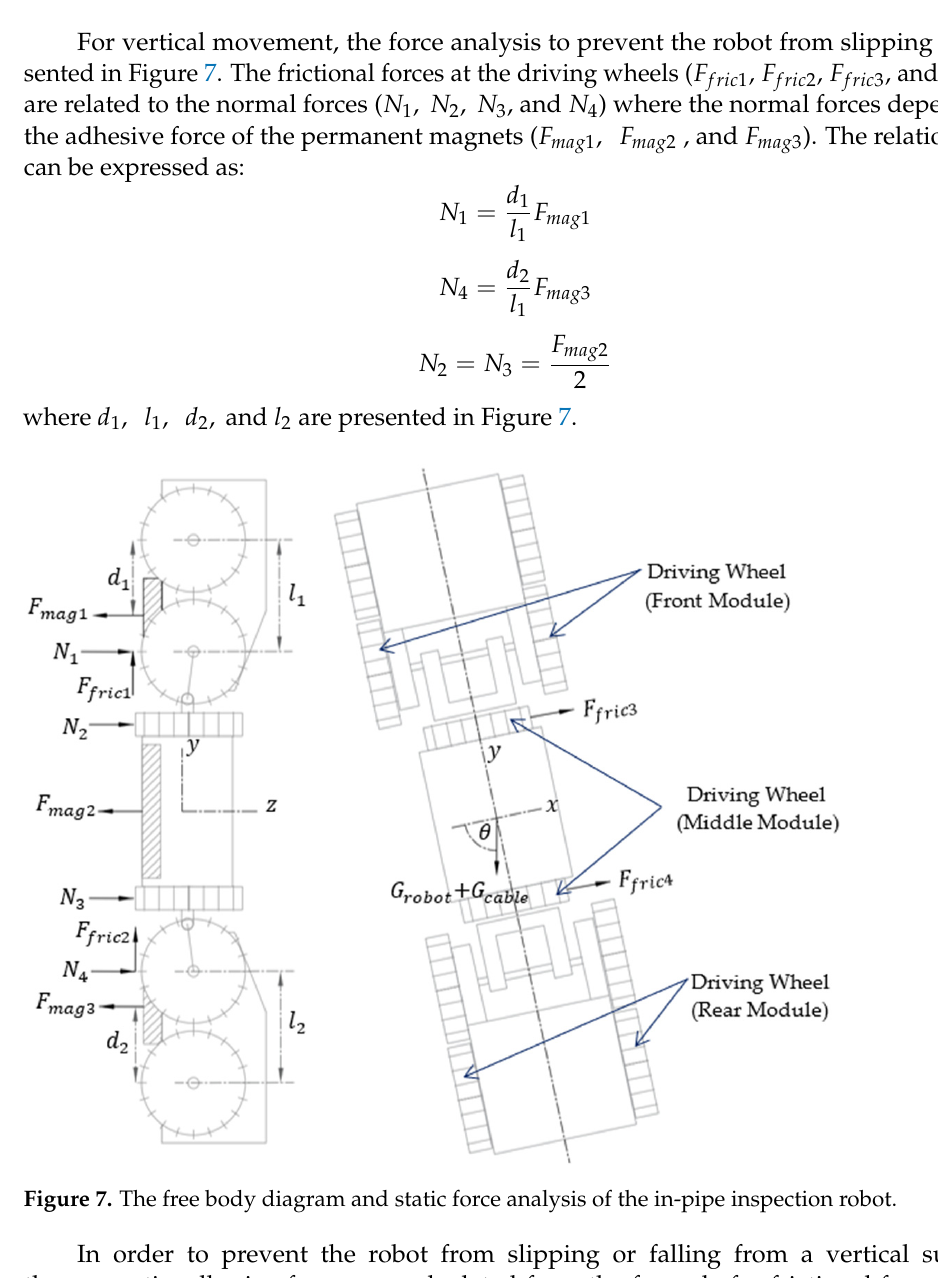
6 of 15 ( b ) Figure 6. The 2D simulation results of the magnetic flux distribution: ( a ) The magnet in the